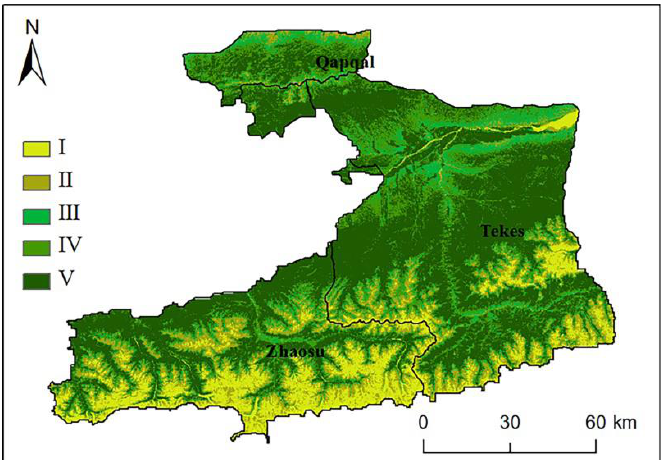
Figure 8. Spatial Distribution of Annual Average FVC in West Tianshan Mountains in the Past 15 Years.